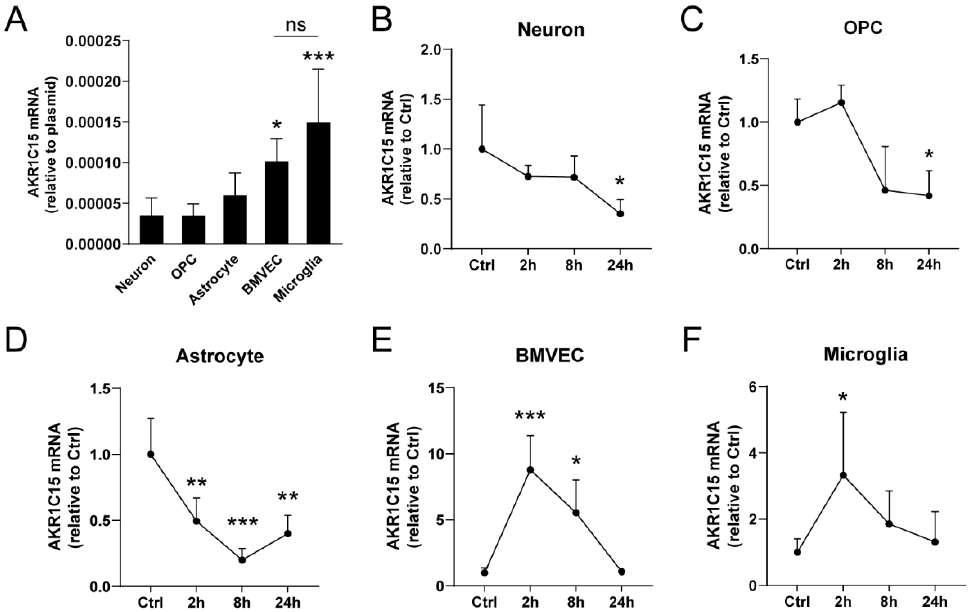
Figure 4. AKR1C15 expression in rat primary CNS cell cultures before and after OGD. AKR1C15 mRNA in primary rat CNS cell cultures was determined by real-time PCR. ( A ) Baseline AKR1C15 expression levels compared to TAT-AKR1C15 plasmid (Biomatik). Data are mean ± SD. n = 6–9 in- dependent experiments. One-way ANOVA followed by Tukey’s multiple comparison. *, *** p < 0.05, 0.001 vs. Neuron. ns: not significant. Cell cultures were then subjected to OGD/reoxygenation, and AKR1C15 mRNA expressions were detected at 2, 8, and 24 h after reoxygenation in cultured ( B ) neurons (1 h OGD), ( C ) OPCs (90 min OGD), ( D ) astrocytes (4 h OGD), ( E ) BMVECs (12 h OGD), and ( F ) microglia (90 min OGD). Data are mean ± SD. n = 4–9 independent experiments. One-way ANOVA followed by Tukey’s multiple comparison. *, **, *** p < 0.05, 0.01, 0.001 vs. Ctrl. OGD: oxy- gen–glucose deprivation. BMVEC: brain microvascular endothelial cell. OPC: oligodendrocyte pre- cursor cell.